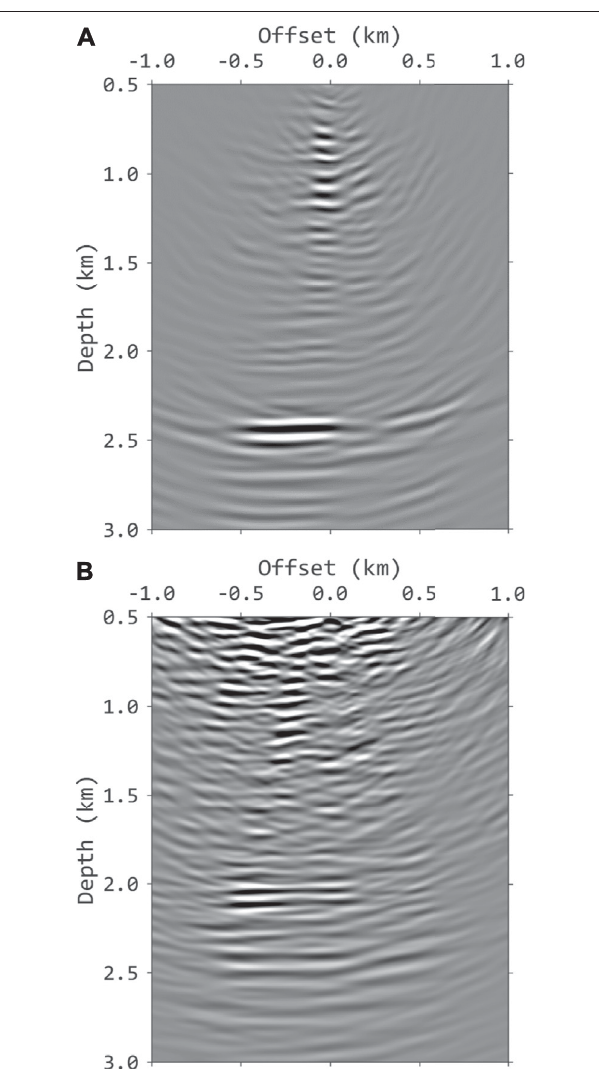
FIGURE 10 | Imaging results of the walkaway VSP fi eld data using cross-correlation imaging condition with wave fi eld decomposition: (A) The image using primaries only. (B) The image using DDM. Compared to (A, B) has enhanced illumination away from the well and images the shallow re fl ectors. Due to the lack of near-offset traces, the zone near the well is not accurately imaged in (B)